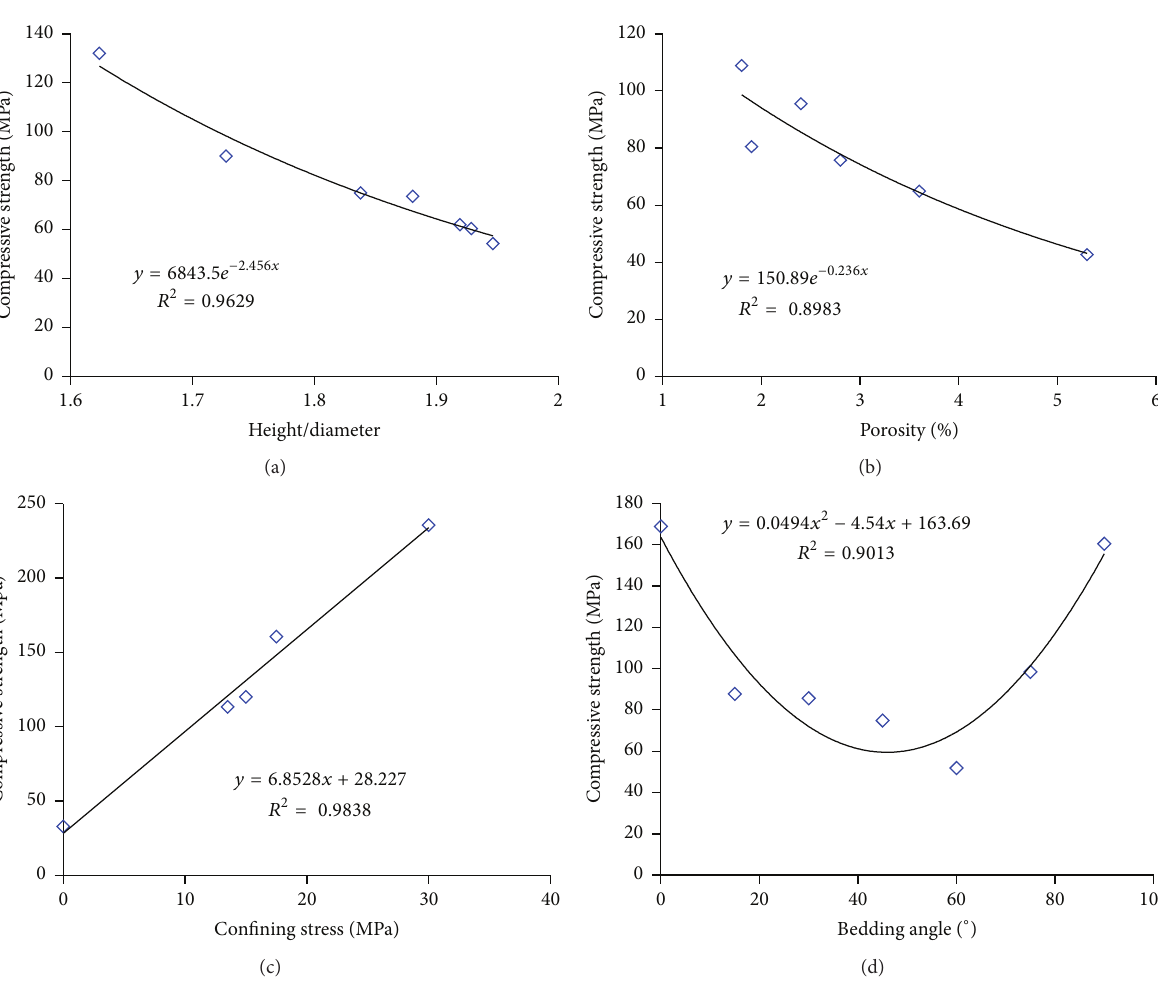
Figure 4: Correlation analysis: (a) height/diameter ratio versus compressive strength; (b) porosity versus compressive strength; (c) confining stress versus compressive strength; (d) bedding angle versus compressive